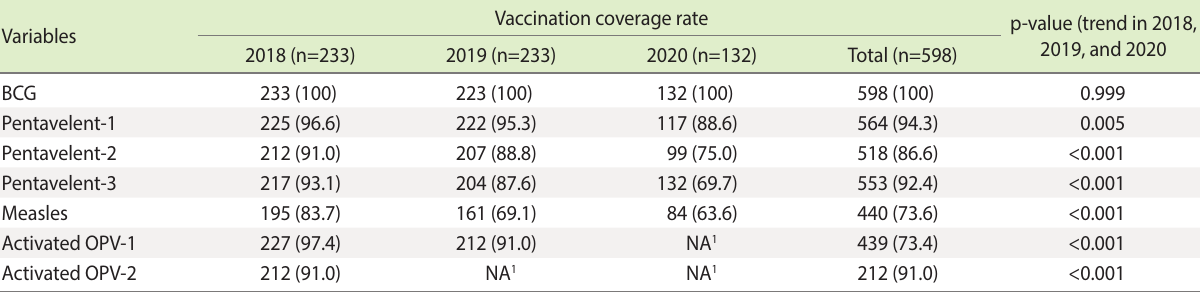
Table 2. The vaccination coverage rate of each vaccine in 2018, 2019, and 2020